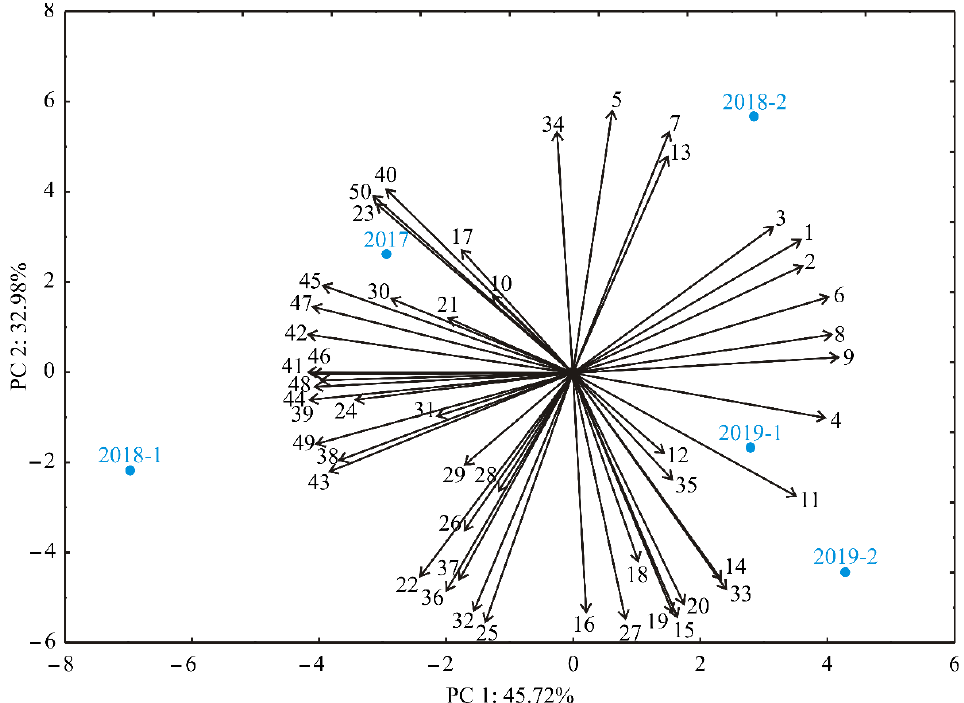
Figure 4. The PCA biplot diagram describing the relations between immortelle EO compounds (marked with black color) of samples from 2017, 2018, and 2019 (marked with blue color) (the compound codes and samples codes are noted in Table 2).